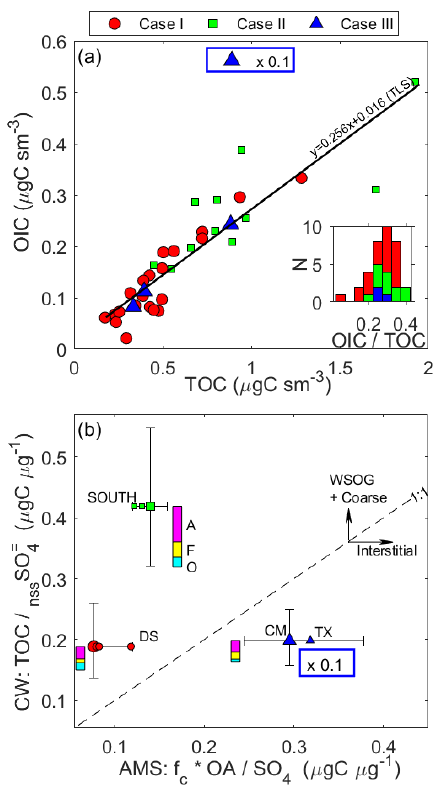
Figure 13. (a) Closure of the sum of the carbon contribution from each measured organic ion – the organic ion carbon (OIC) – against measured total organic carbon (TOC), with Case III scaled by a factor of 10 to aid readability. Inset is a histogram of the OIC:TOC ratio colored by case, and a total-least-squares (TLS) best fit line for the OIC–TOC closure is included. (b) Closure analysis for CW TOC and sub-cloud organic aerosol (OA) from the AMS. The CW data are normalized by CW nss SO 2 − , and OA data are scaled by an 4 estimate of carbon mass fraction ( f c ) and normalized by AMS SO 4 . “Air-mass” means are included with a 1 σ bar aligned with the “air mass” most relevant to the cloud (as per Fig. 9; here, only outlying air masses are labeled to aid readability). As in panel (a) , Case III is scaled by a factor of 10. The contributions to TOC arising from measured acetate (A), formate (F) and oxalate (O) are shown next to each case with the same